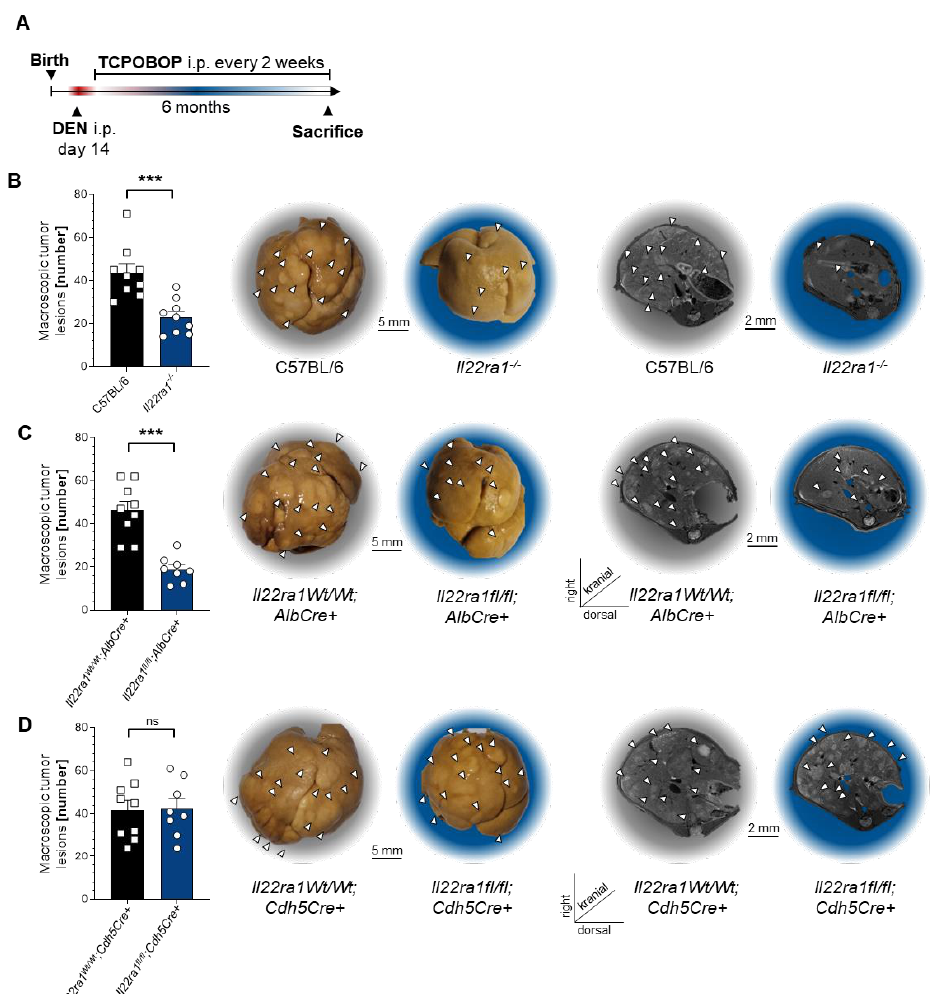
Figure 4. IL-22 signaling in hepatocytes promotes HCC development. ( A ) A schematic timeline describing chemical HCC induction with DEN and TCPOBOP in mice; ( B ) left: number of macroscopic tumor lesions in livers of 6-month-old mice that were either wild type (C57BL/6, left, black, n = 9), or Il22ra1 -deficient ( Il22ra1 -/- , right, blue, n = 8); middle: representative macroscopic pictures; right: representative MRI pictures; ( C ) left: number of macroscopic tumor lesions in livers of 6-month-old mice that were either controls ( Il22ra1 +/+ ; Alb Cre+ , left, black, n = 9), or deficient for Il22ra1 on hepatocytes ( Il22ra1 flox/flox ; Alb Cre+ , right, blue, n = 8); middle: representative macroscopic pictures; right: representative MRI pictures; ( D ) left: number of macroscopic tumor lesions in livers of 6-month-old mice that were either controls ( Il22ra1 +/+ ; Cdh5 Cre+ , left, black, n = 9), or deficient for Il22ra1 on endothelial cells ( Il22ra1 flox/flox ; Cdh5 Cre+ , right, blue, n = 8); middle: representative macroscopic pictures; right: representative MRI pictures. Data are pooled from 2 independent experiments. Data presented as mean ± SEM. ns: p > 0.05; ***: p ≤ 0.001 as assessed by Mann – Whitney U test.